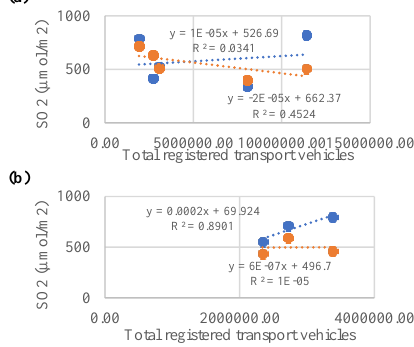
Figure 14. Influence of total registered transport vehicles on SO 2